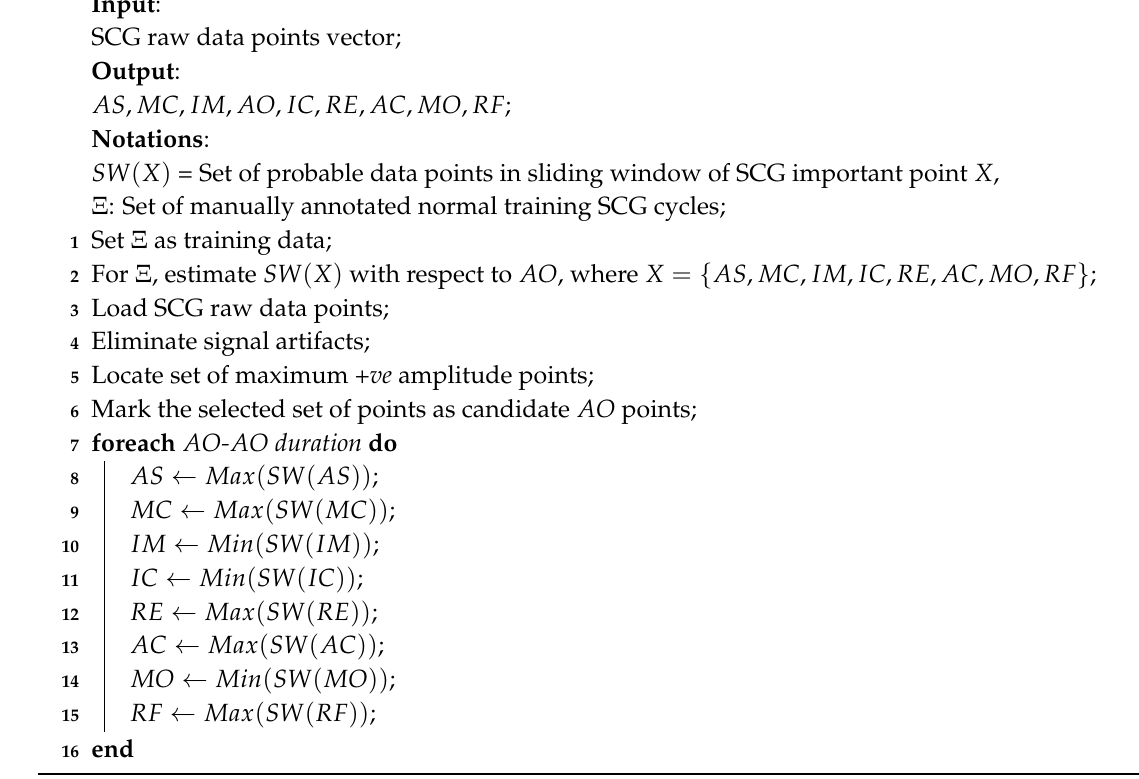
Algorithm 2: Selection of important points of SCG.